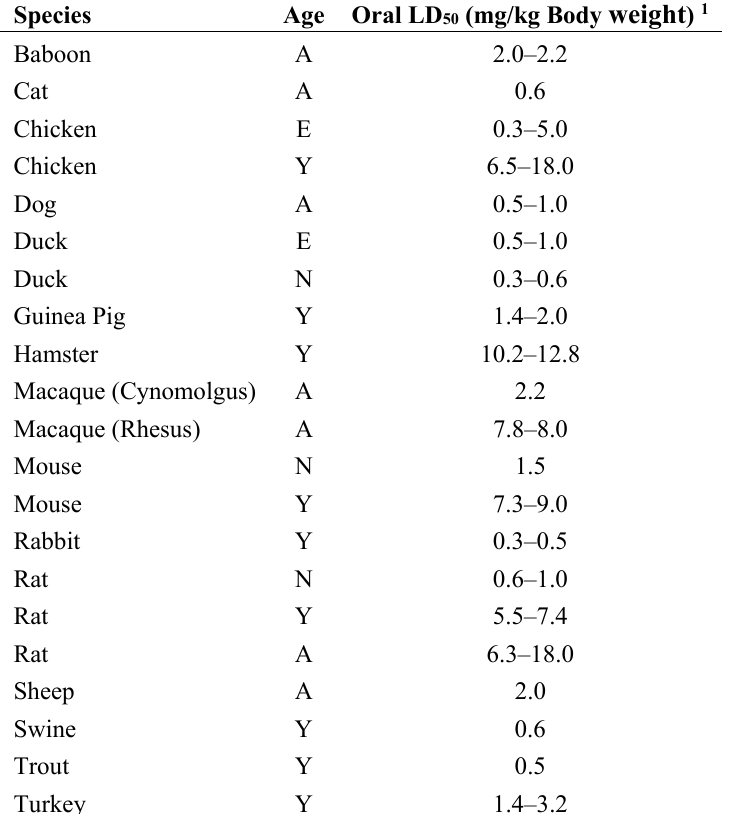
Table 1. Comparative acute toxicity of a single oral dose of aflatoxin B 1 (AFB 1